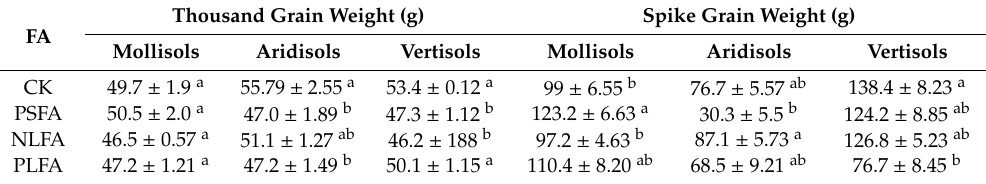
Table 2. E ff ect of FA on wheat grain weight and the spike grain weight of wheat (g pot − 1 ). FA